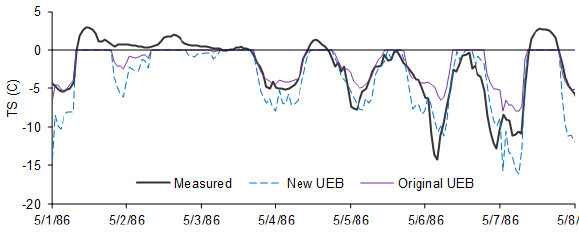
Figure 9. Comparisons of snow water equivalent in 1986 at CSSL.